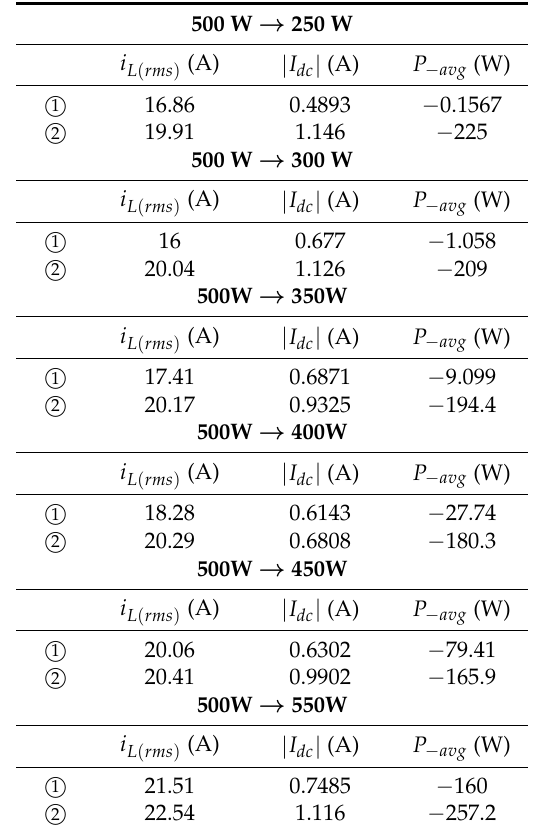
Table 3. Comparison of indexes under each transient DAB model.